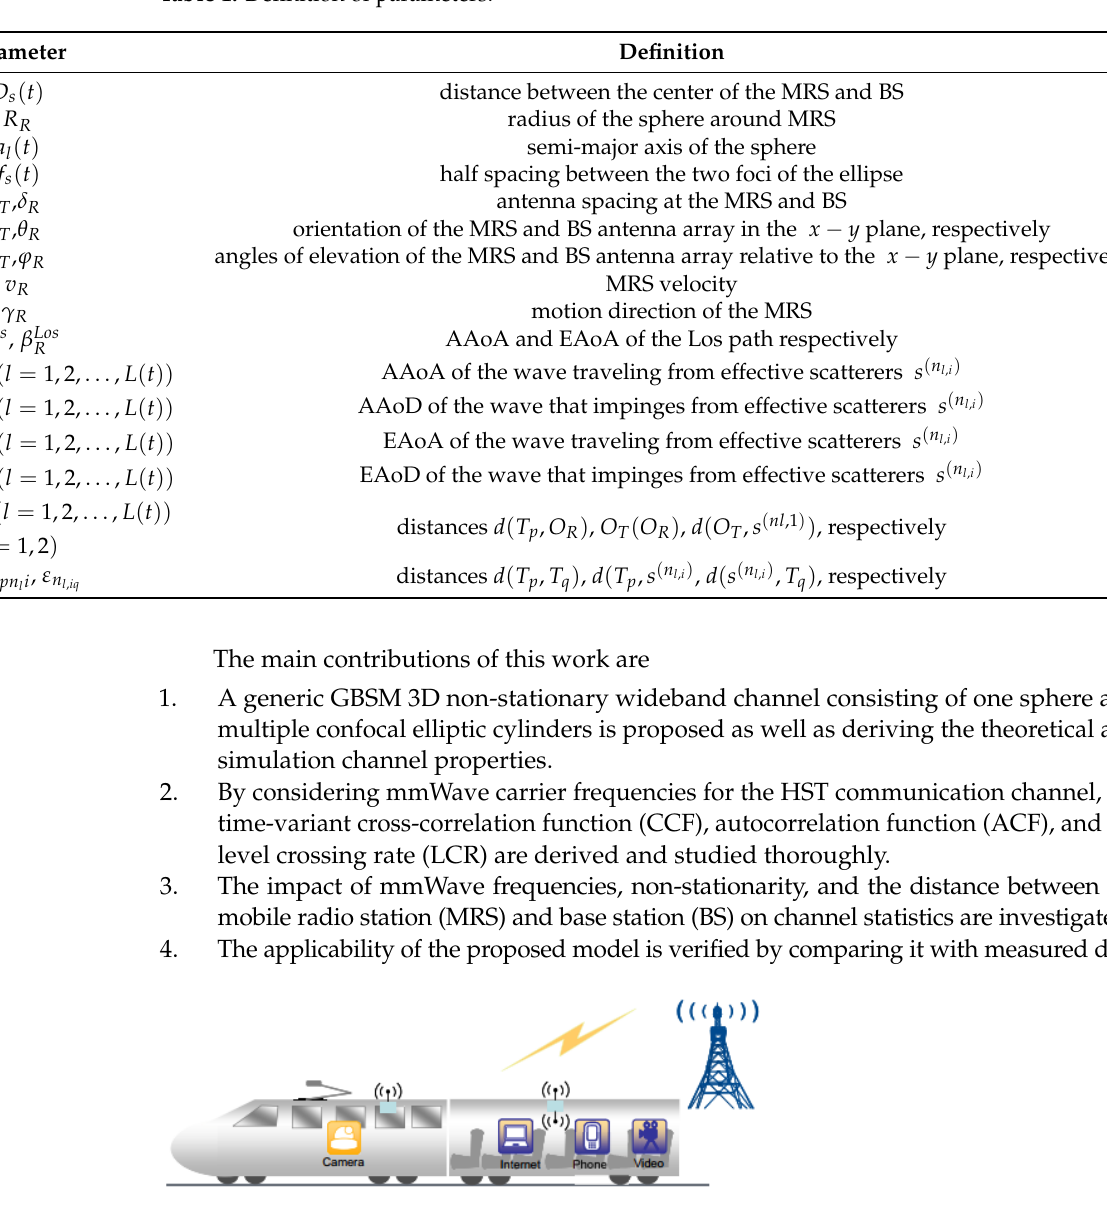
Table 1. Definition of